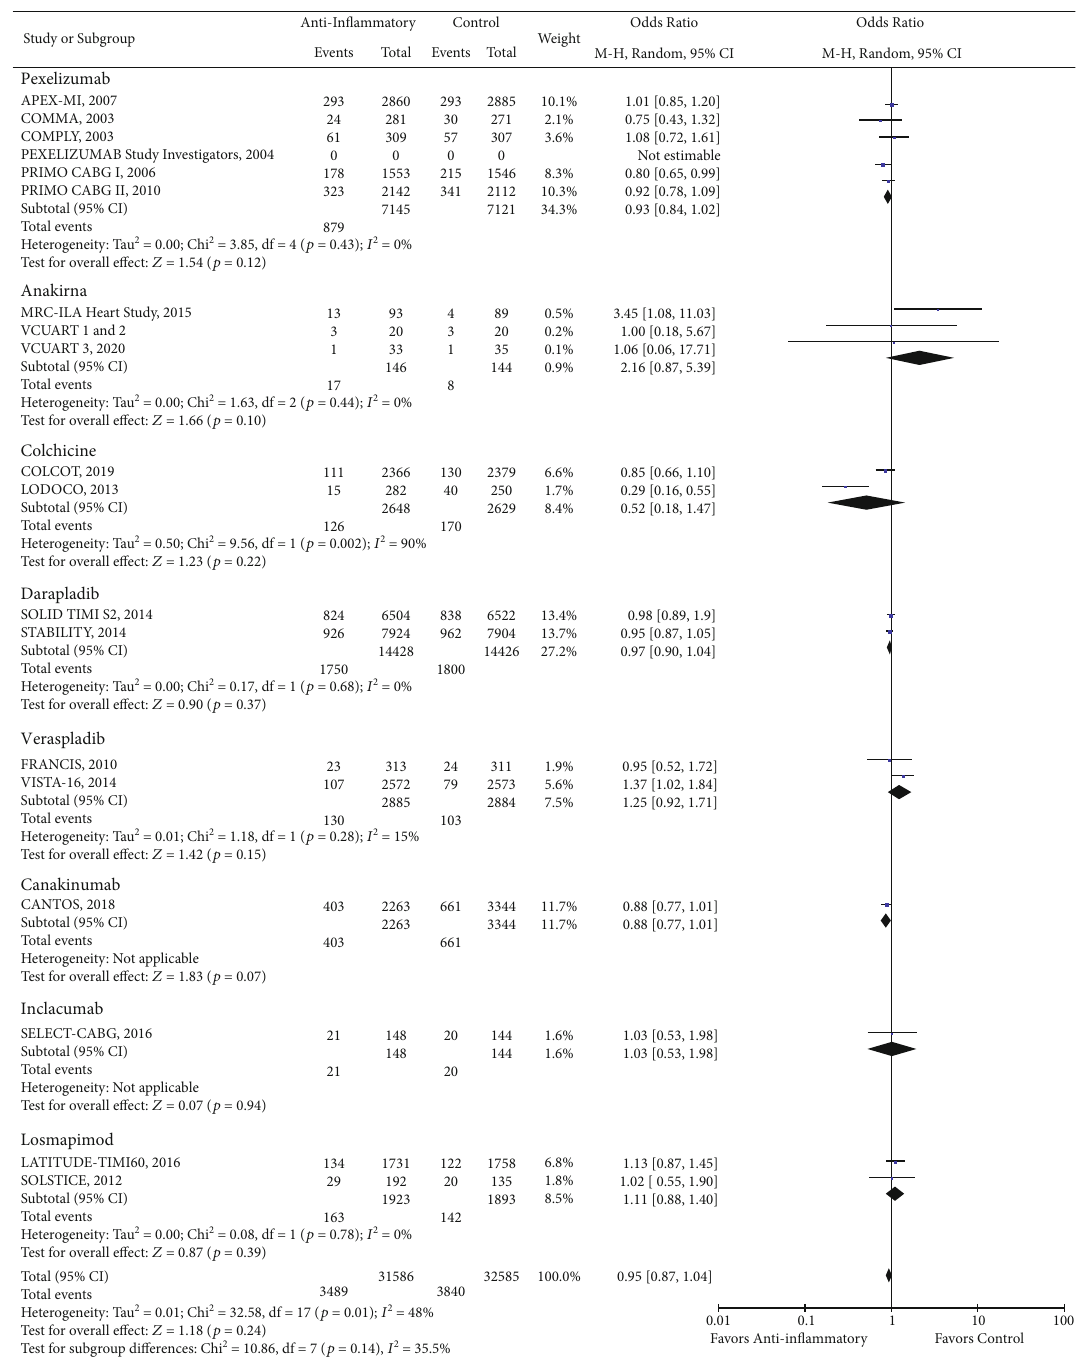
Figure 7: Forest plot of MACCE. There was no signi fi cant di ff erence between anti-in fl ammatory therapy and standard therapy alone regarding MACCE (OR 0.95, CI 0.87-1.04; P = 0 : 24